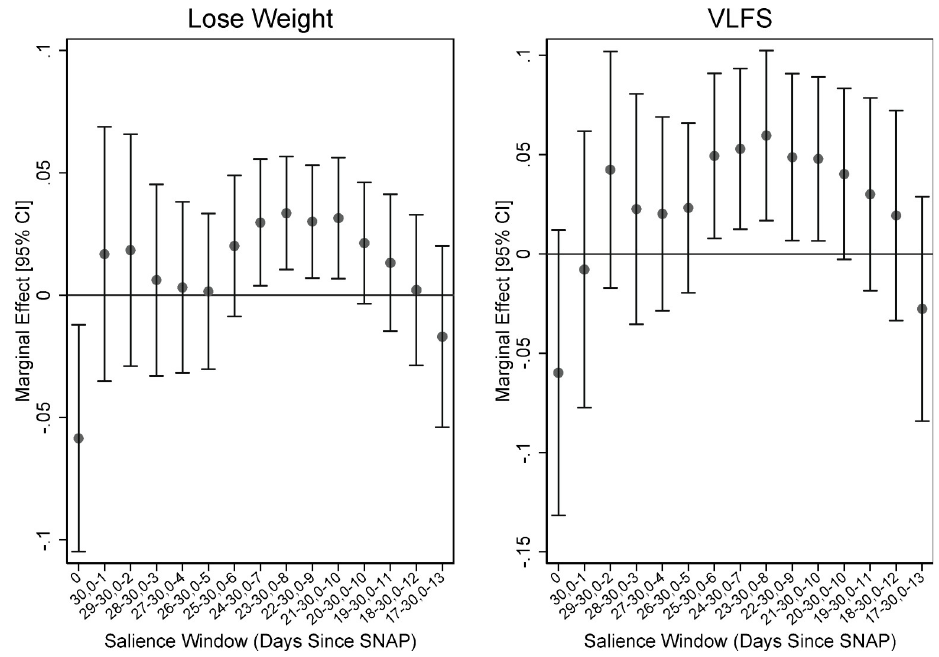
Fig 3. Varying the bounds of salience window: FSM item lose weight and VLFS. Source: Authors’ calculations using NHANES data. N = 7,919. Regression estimates are weighted.